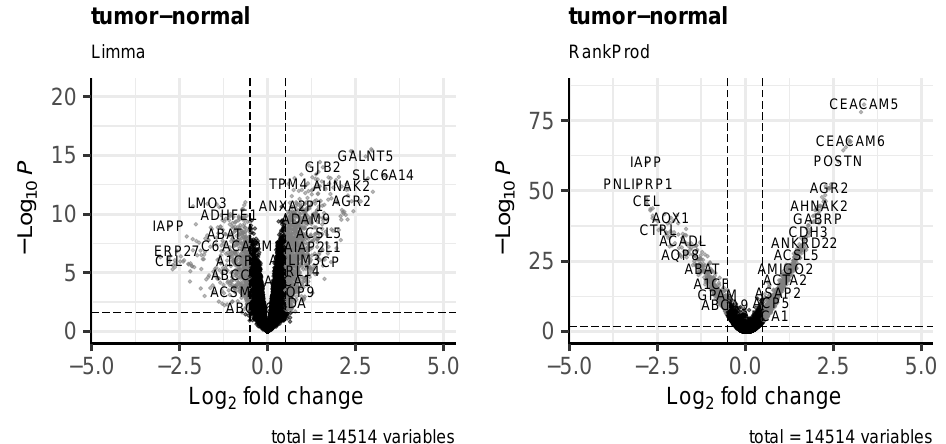
Figure 5. Volcano plots of the DEGs detected by limma (left) and RankProduct (right) in the Zhang data set. The different shapes of the distributions are related to how the two algorithms compute ( p -value ) threshold corresponding to an FDR the p -values. The horizontal dashed line is the − log 10 alpha level of 0.05. The vertical lines are the log fold-change thresholds, which can be changed by 2 the user and are by default set to